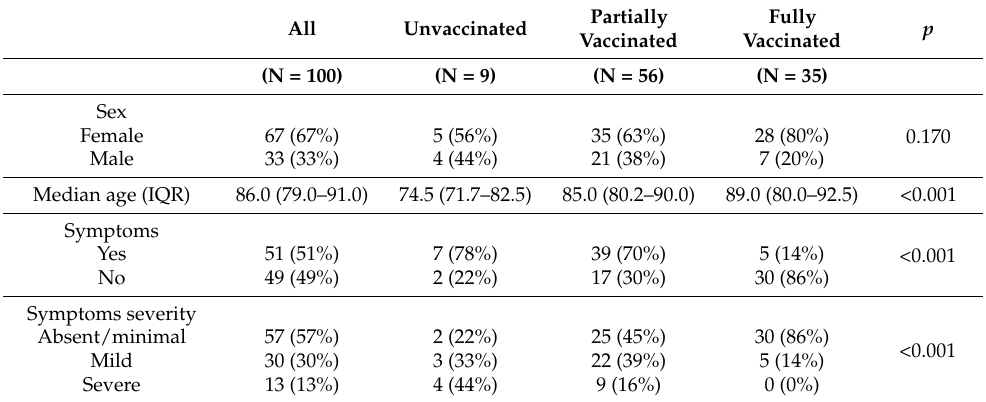
Table 1. Demographic and clinical characteristics of SARS-CoV-2 cases, according to vaccination status.